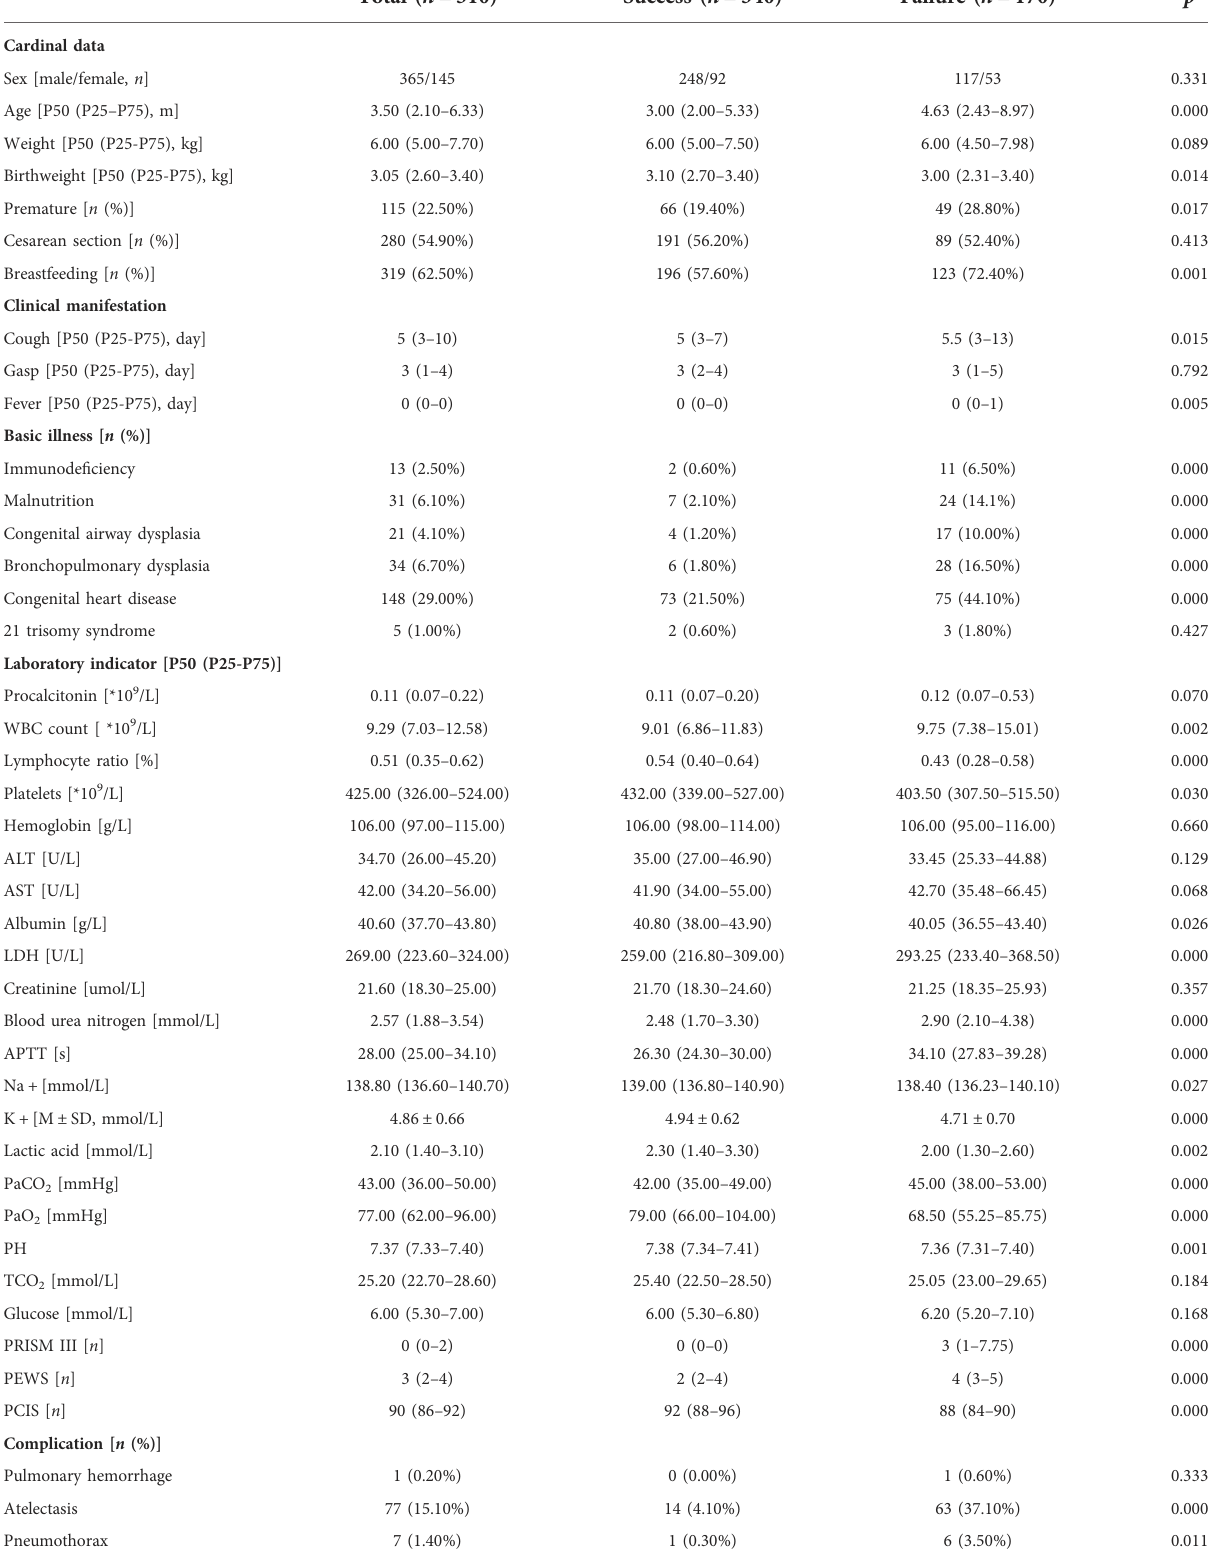
TABLE 1 Clinical data of two groups of children with